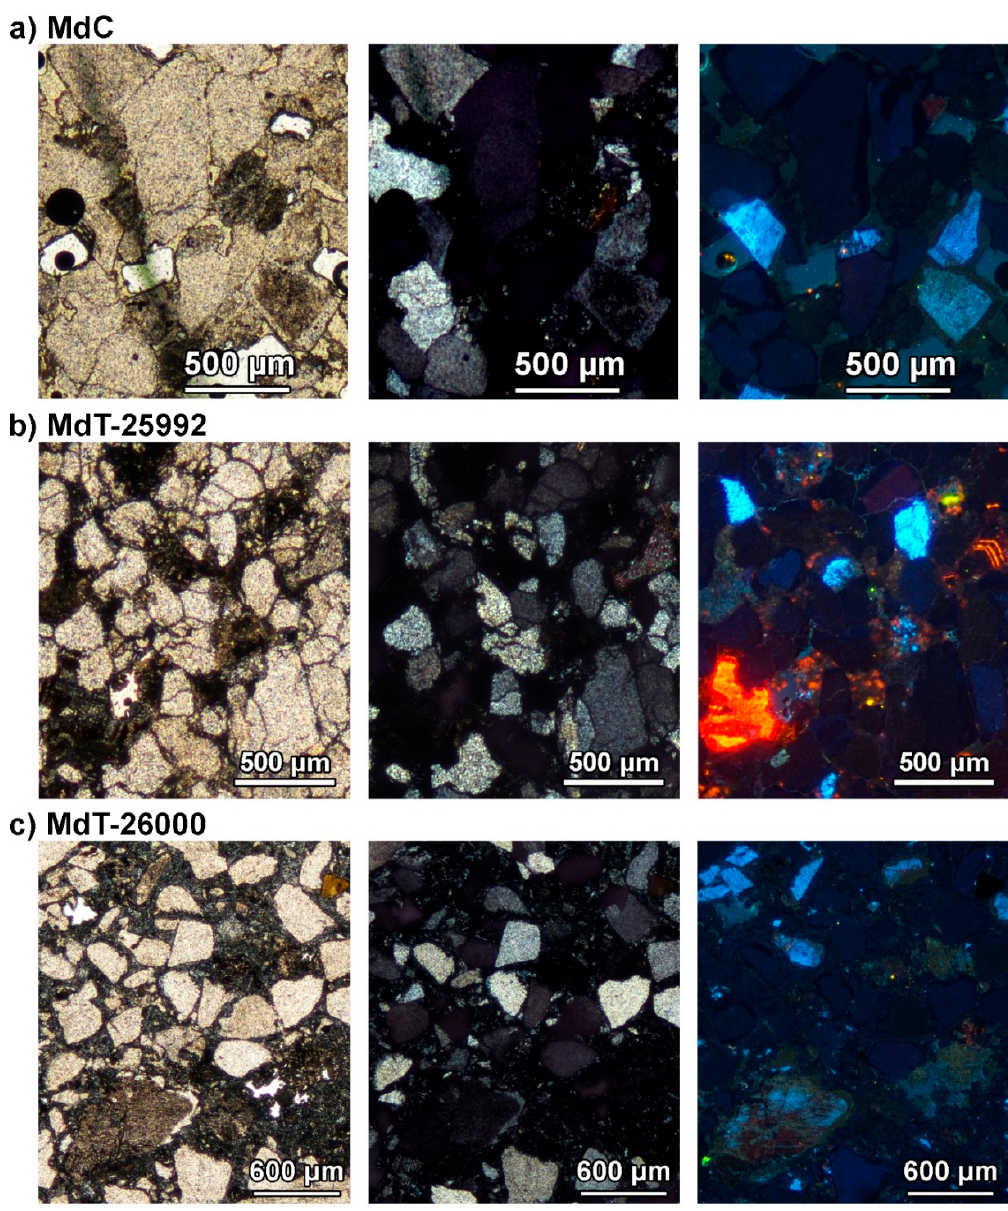
Figure 11. Petrographic images of the sampled pieces found outside Barcino including PPL (left), XPL (middle), and CL (right) micrographs of the same areas. ( a ) Sample of MdC stele, exhibiting typical features of Montjuïc sandstone (K-feldspar and quartz clasts with authigenic overgrowths). ( b ) Sample of MdT-25992 frieze, exhibiting K-feldspar and quartz clasts, only the latter with authigenic overgrowths and carbonate components (orange in CL mode). ( c ) Sample of MdT 26000 acroterion, exhibiting typical features of Montjuïc sandstone.